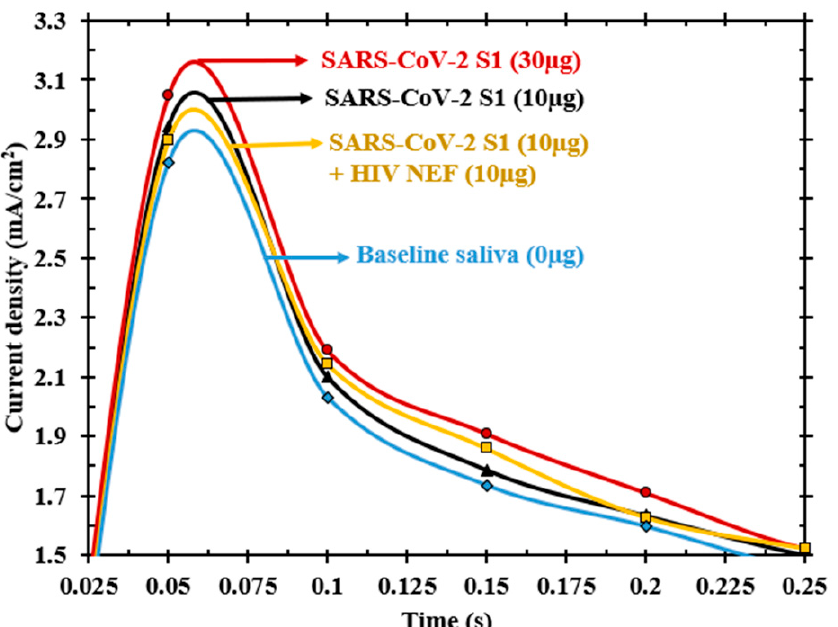
Figure 5. Electric current responses recorded as a function of time from artificial saliva without any proteins (blue), with 10 µg S1 protein (black), with 10 µg S1 protein (red) and solution mixed with 10 µg S1 protein and 10 µg NEF protein (yellow). The plot emphasizes that the use of artificial saliva has not affected the measurement of SARS-CoV-2 protein and that there are no interferences in the measurement due to presence of proteins from another virus.